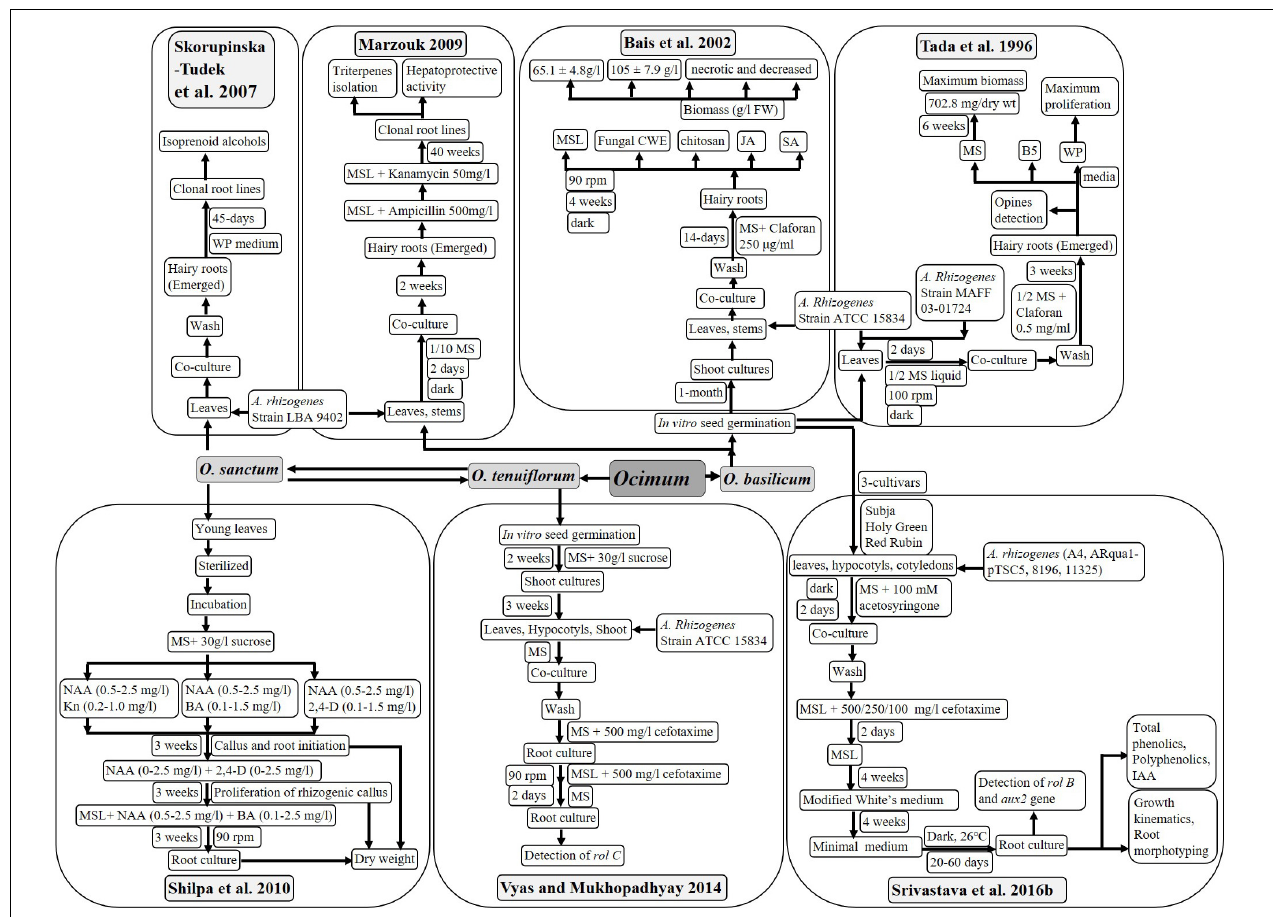
FIGURE 5 | Hairy root and in vitro root cultures of Ocimum basilicum and Ocimum